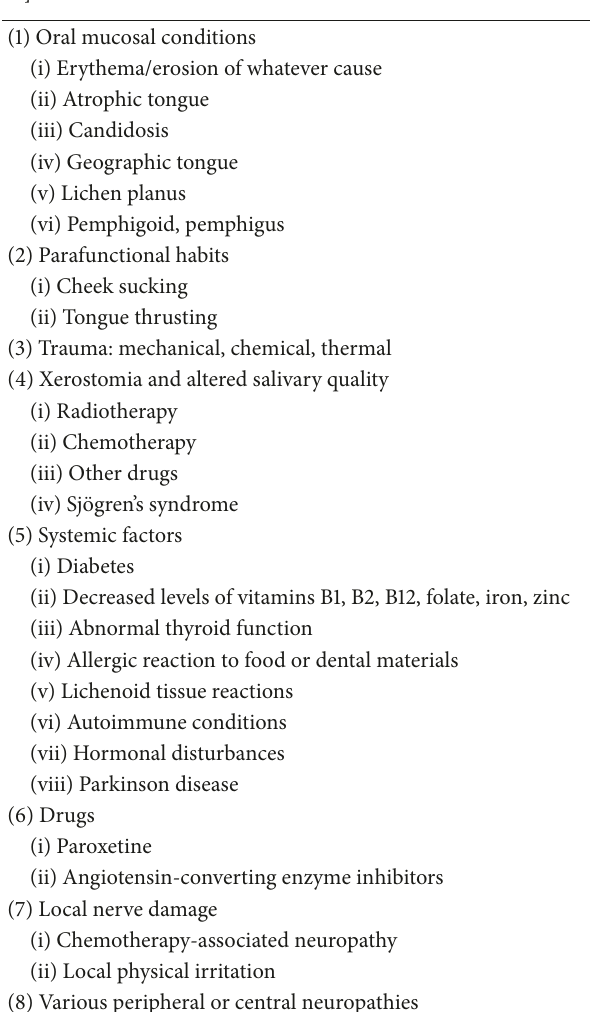
Table 1: Some systemic and local causes of a burning sensation in the mouth, which, therefore, by definition is not BMS [4, 8, 12, 13, 18, 26].